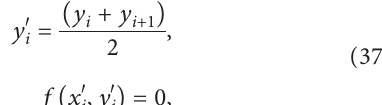
Figure 8: A clamped circular